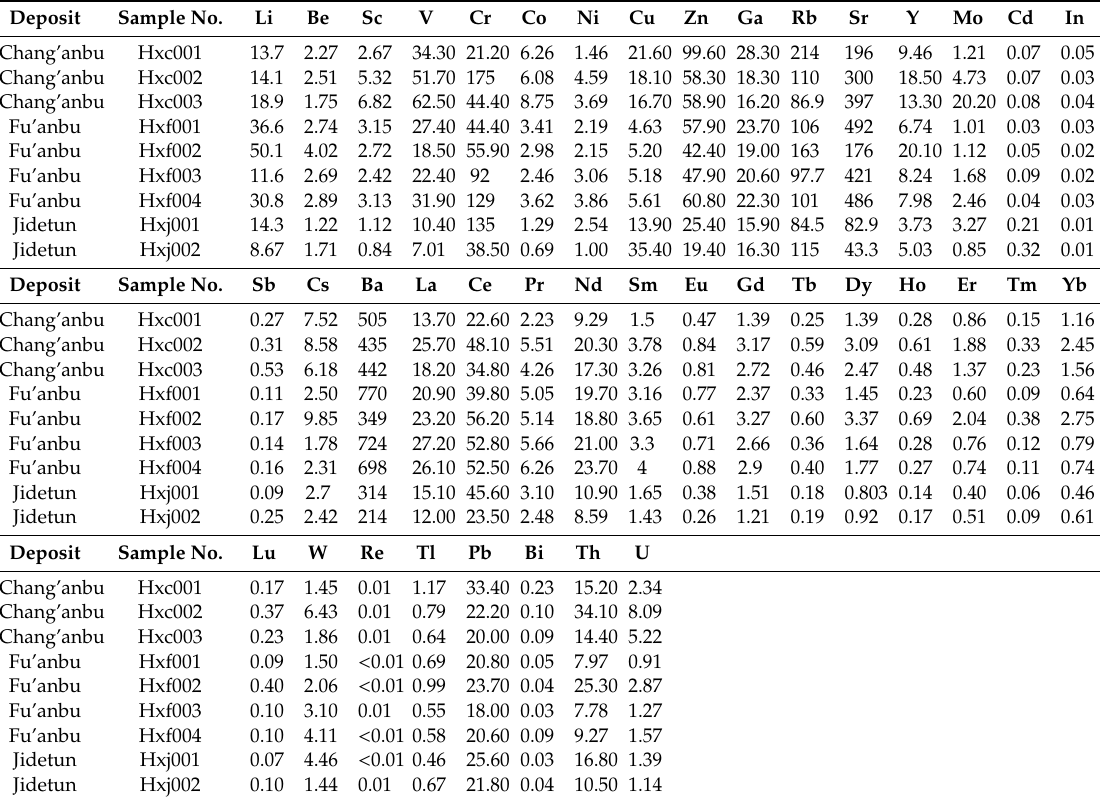
Table 5. Trace element data for ore-hosting rocks from the Chang’anbu, Fu’anbu, and Jidetun ore deposits